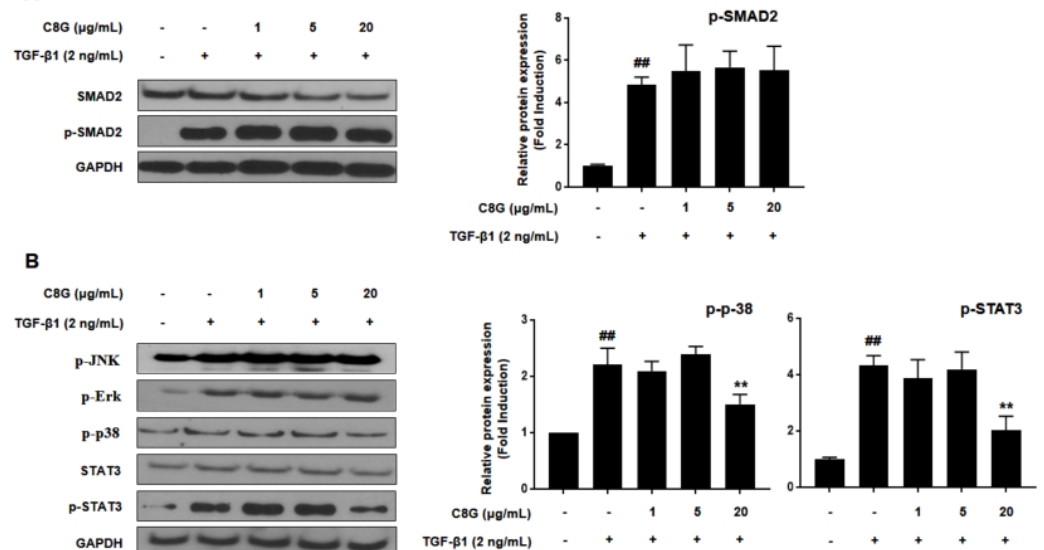
Figure 4. C8G suppressed STAT3 phosphorylation and translocation in LX-2 cells activated by TGF- β 1. LX-2 cells were treated with C8G for 48 h after activation by TGF- β 1 for 48 h. The protein